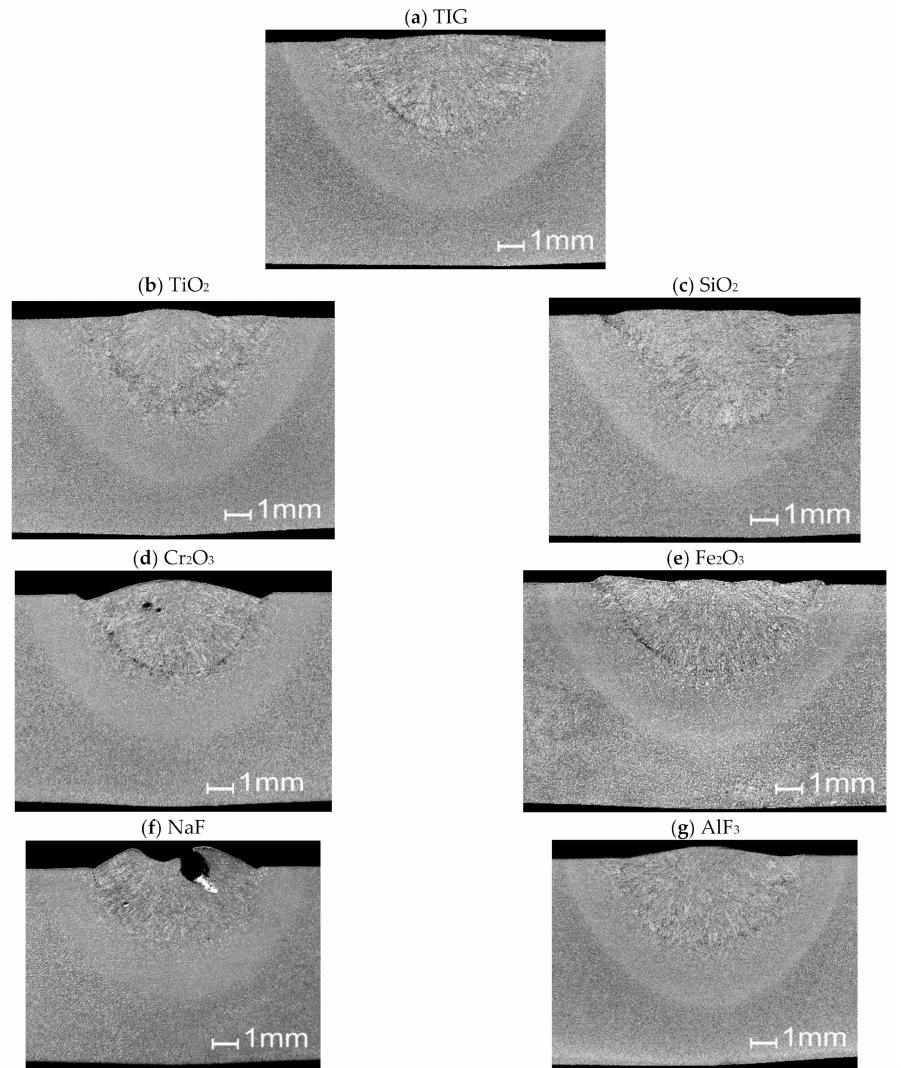
Figure 2. Macrostructure of the welds made on steel S235JR+N using ( a ) conventional TIG without flux and A-TIG with various fluxes: ( b ) TiO 2 ( c ) SiO 2 ( d ) Cr 2 O 3 ( e ) Fe 2 O 3 ( f ) NaF ( g ) AlF 3